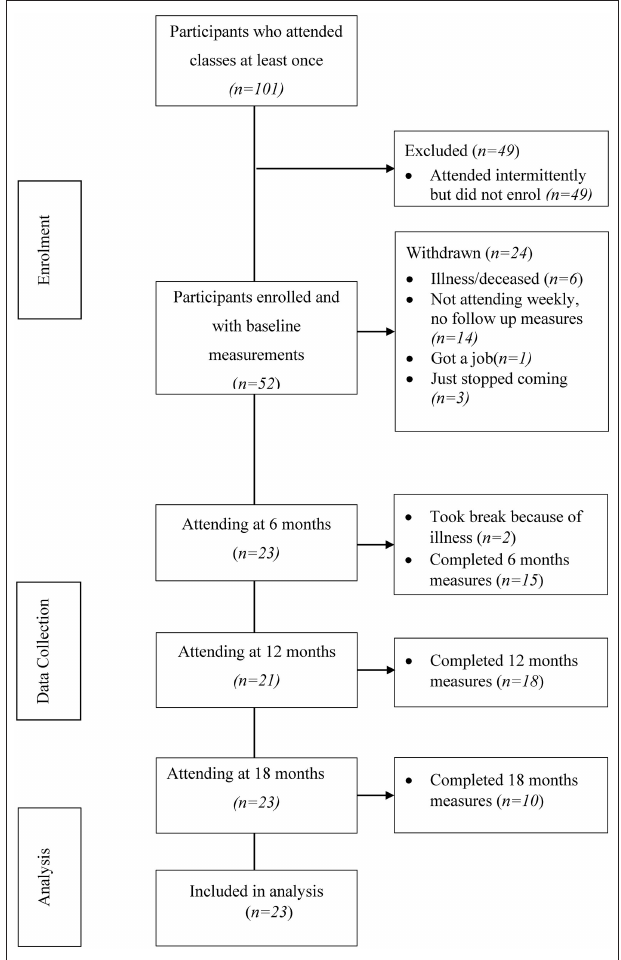
FIGURE 1 | Participant flow through the